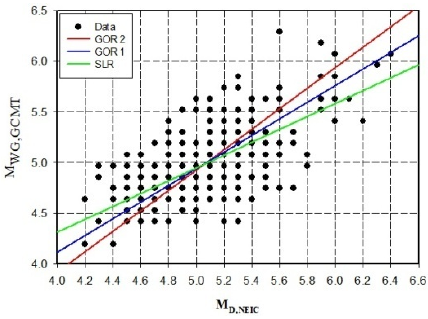
Figure 13. The (M D − M wg ) data, as well as the GOR1, GOR2, and SLR regression lines.